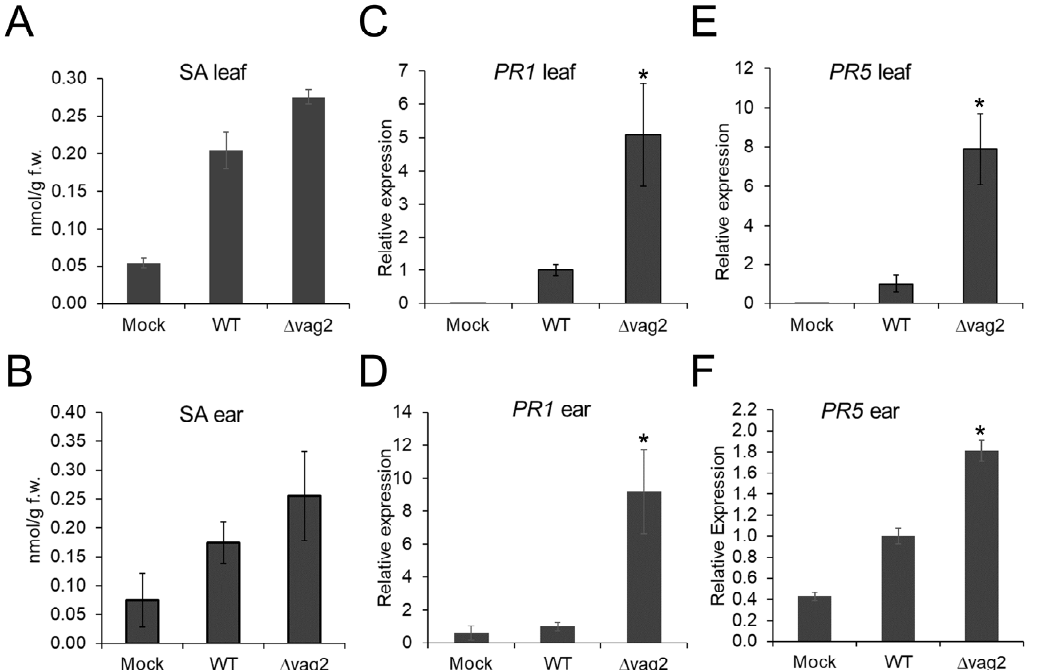
Figure 6. SA and SA-induced defense genes are upregulated in maize colonized by S. reilianum lacking vag2 . ( A , B ) SA levels were quantified in maize tissues inoculated with S. reilianum wildtype (WT) and ∆ vag2 deletion strains ( ∆ vag2), or with water (Mock). Samples were collected from maize leaves below the inoculation site at 6 dpi ( A ), or of maize ears collected at 31 dpi ( B ). ( C – F ) Relative expression of the SA-induced defense genes PR1 (AC205274.3_FG001) and PR5 (GRMZM2G402631) was measured by real-time PCR. Samples were collected from inoculated leaves at 6 dpi ( C , E ) and from ears at 31 dpi ( D , F ) and used for extraction of total RNA. RNA samples were subjected to qRT-PCR with PR1 and PR5 gene-specific primers (Table S2). Expression levels of PR1 ( C , D ) and PR5 ( E , F ) were normalized to the maize actin reference gene (GRMZM2G126010), and expression of WT was set to 1. For each biological replicate, leaves or ears of 10 different plants were collected. Error bars indicate SEM of three biological replicates, and asterisks indicate a significant difference (Student’s t- test, * p < 0.05) of mutant relative to wildtype-inoculations.